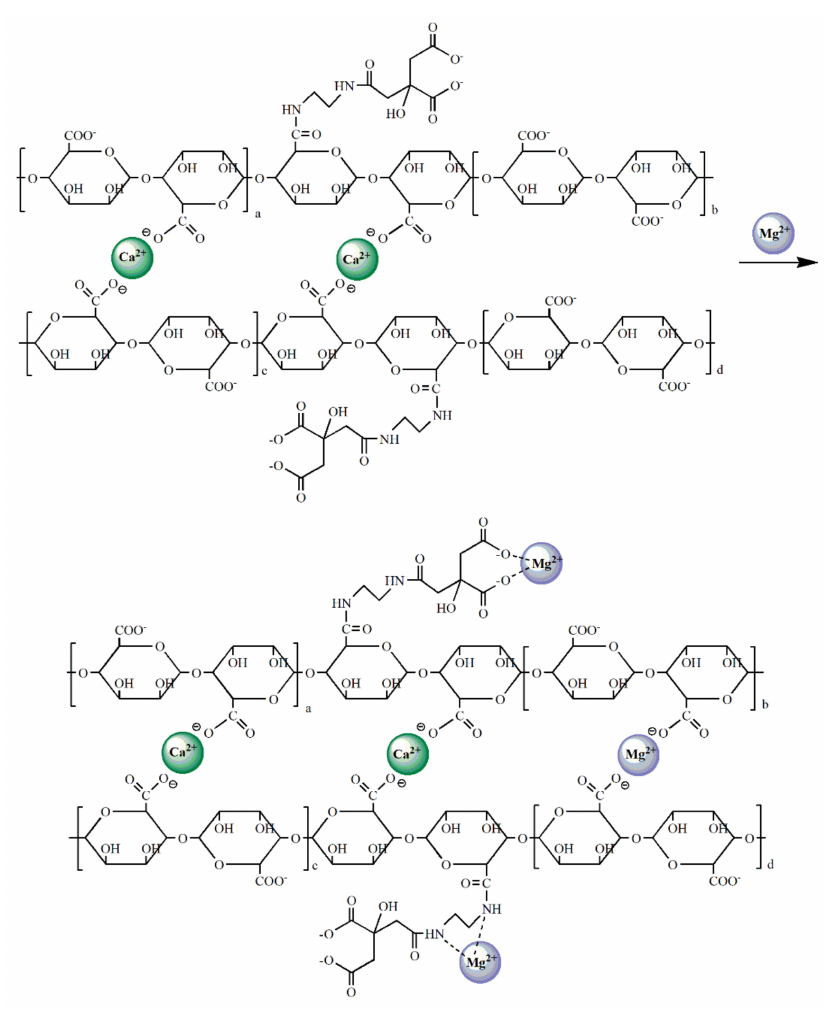
Figure 9. Possible adsorption mechanism of the CA–SC to Mg 2+ .